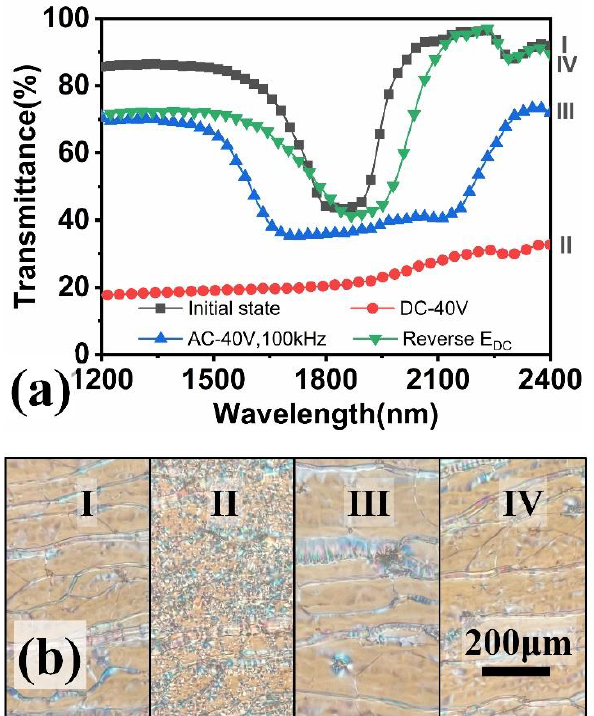
Figure 3. Ultraviolet transmission spectrum ( a ) and corresponding POM texture picture ( b ) of sample 5 during electric tuning (I initial state, II with DC electric field (E DC = 40 V), III with high-frequency AC electric field (E AC = 40 V@ f = 100 kHz), IV with DC electric field (E DC = − 40